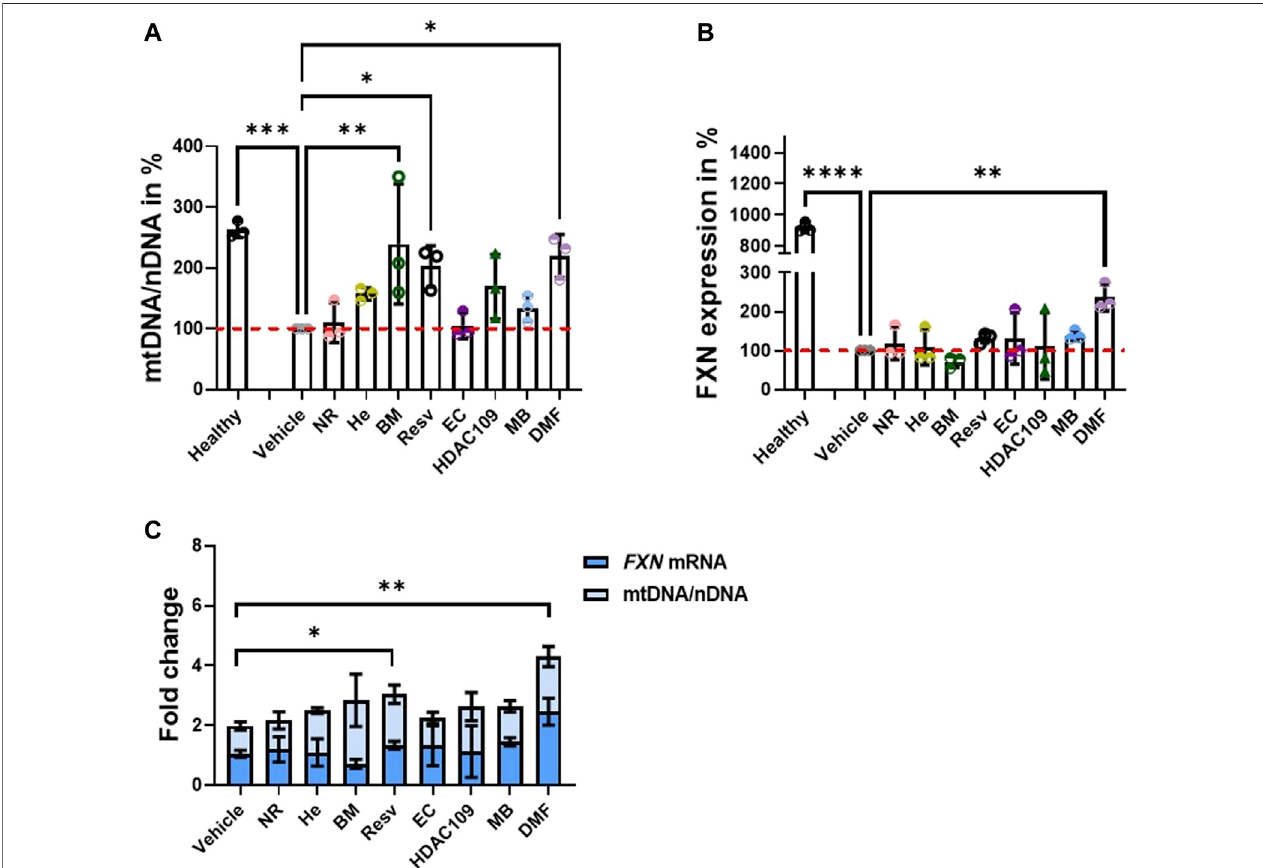
FIGURE1| Testingtheabilityofdrugstopromotemitochondrialbiogenesisand FXN increaseintheFApatientcellline.Forty-eighthourspriortocellharvesting,the differentcompoundswereadministered. (A) HistogramrepresentsthelevelsofmtDNA/nDNAinpercentages.Resultswerecomparedtovehicle(FAcellsuntreated)and showedthatBM,Resv,andDMFincreasedsigni fi cantlymtDNA(mean±SD;healthy263±13,NR109.9±32.7,He157.2±10.21,BM239.4±98.86,Resv202.6±34, EC105.1±21,HDAC109169.6±53,MB133.9±21.5,DMF220±35.3;one-wayANOVAwithDunnett ’ smultiplecomparisonstest). (B) Resultswerecompared to vehicle (FA cells untreated); the histogram shows the FXN mRNA levels in percentage where most of the drugs showed an increase in expression, but DMF was the mostef fi cacious. BMdoesnotappeartoincrease FXN (mean±SD;healthy919.5±30.4,NR118.5±41.45,He108.9±45.45,BM71.3±14.6,Resv132.7±13.1,EC 131 ± 66, HDAC 109 111.6 ± 85.3, MB 139 ± 12.6, DMF 236 ± 34.5; one-way ANOVA with Dunnett ’ s multiple comparisons test). (C) Plot combines FXN mRNA levels